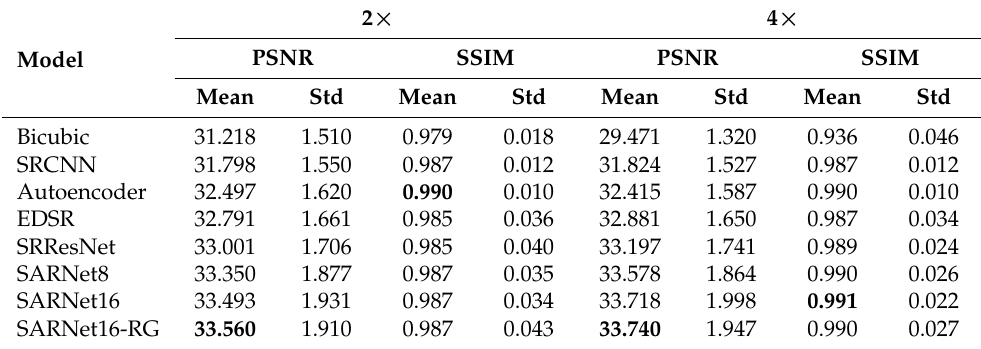
Table 5. PSNR and SSIM metrics obtained with different models for the test